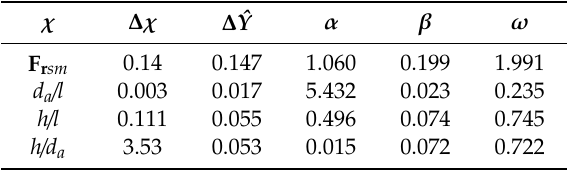
Table 2. Results of sensitivity analysis with 10% increment in Δχ .